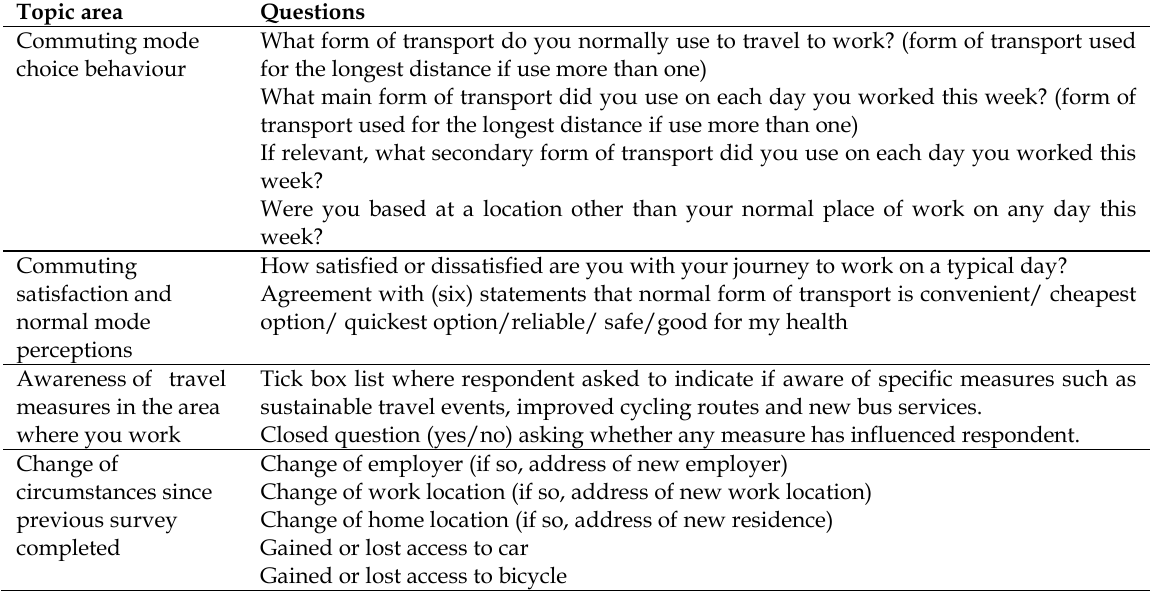
Table 2. Panel survey topic areas and